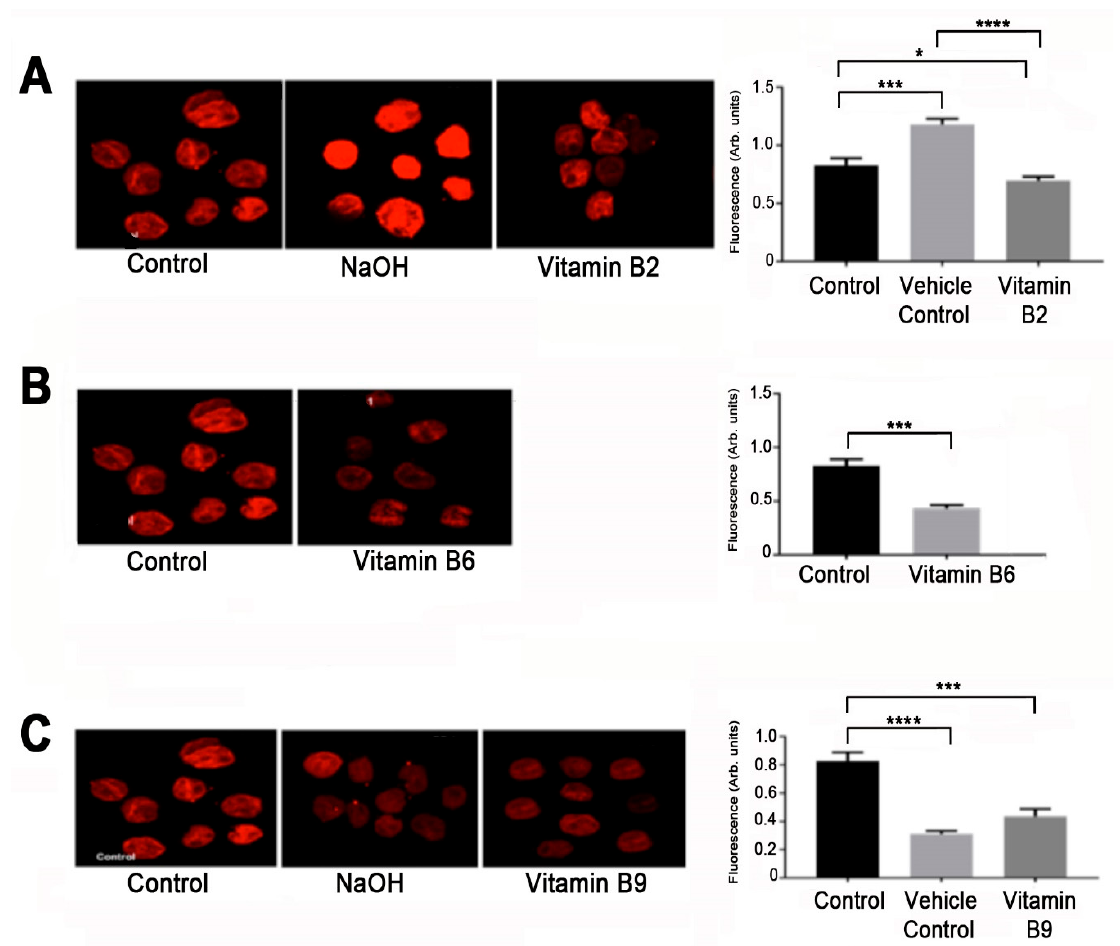
Figure 4. Expression of PD-L1 as assessed by confocal imaging on U937 cells in the presence of ( A ) vitamin B2 at 0.125 µ g / mL and vitamin B2 vehicle control (NaOH) and untreated control. ( B ) Vitamin B6 at 125 µ g / mL and untreated control, and, ( C ) vitamin B9 at 125 µ g / mL and untreated control. (* p < 0.05, *** p < 0.001, **** p < 0.0001